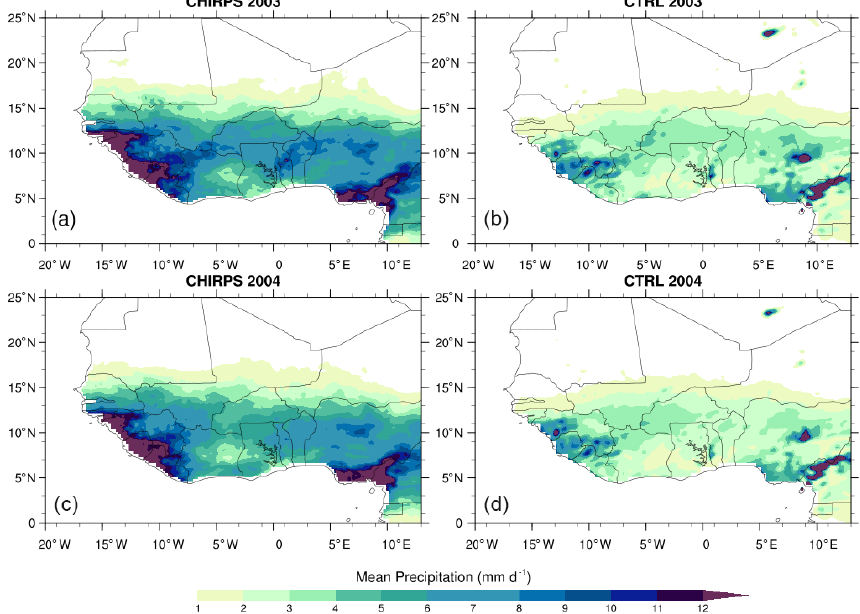
Figure 3. Mean precipitation (mmd − 1 ) from CHIRPS (a, c) and the simulated control experiments (CTRL) (b, d) using the reanalysis initial soil moisture from ERA-20C during JJAS 2003 and JJAS 2004.